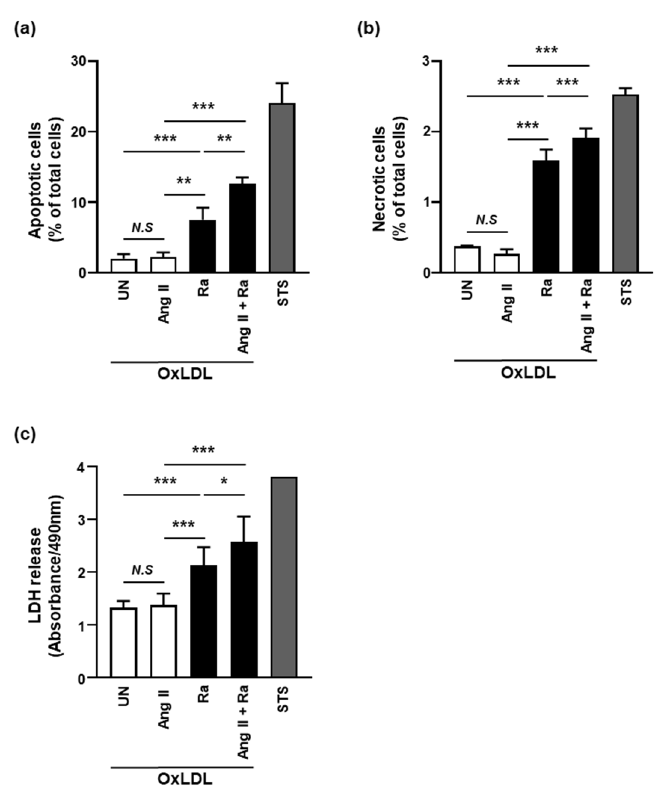
Figure 5. OxLDL accumulation provides a favorable environment for the growth of mycobacteria in Ang II-stimulated macrophages. ( a – c ) Raw 264.7 cells were pretreated with Ang II (1 μM) for 1 h followed by incubation with 25 μg/mL OxLDL after Mtb H37Ra (MOI = 1) infection. ( a , b ) Cell death was examined by FACS analysis with annexin V/PI staining at 24 h after Mtb infection. Staurosporine (STS, 500 nM, 6 h) was used as a positive control for cell death. ( c ) Released LDH in the culture supernatant was measured by determining the absorbance at 490 nm (A490) at 24 h after infection. Data are representative of three independent experiments (* p < 0.05, ** p < 0.01, *** p < 0.005).